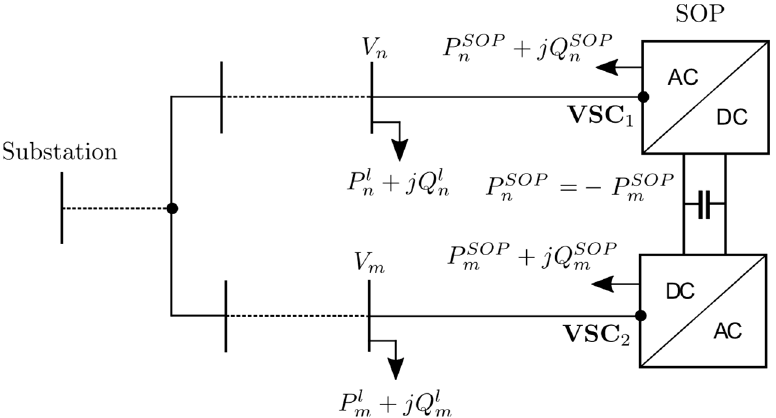
Figure 2. SOP model placed at tie